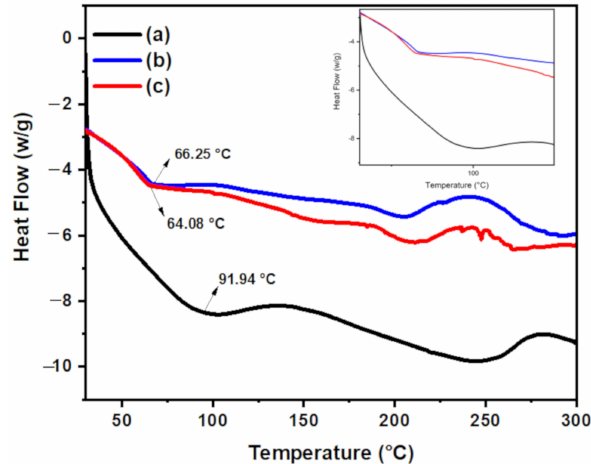
Figure 4. Di ff erential scanning calorimetry (DSC) thermogram for ( a ) chitosan (CT), ( b ) CT- g -PAA, and ( c ) CT- g -PAA /